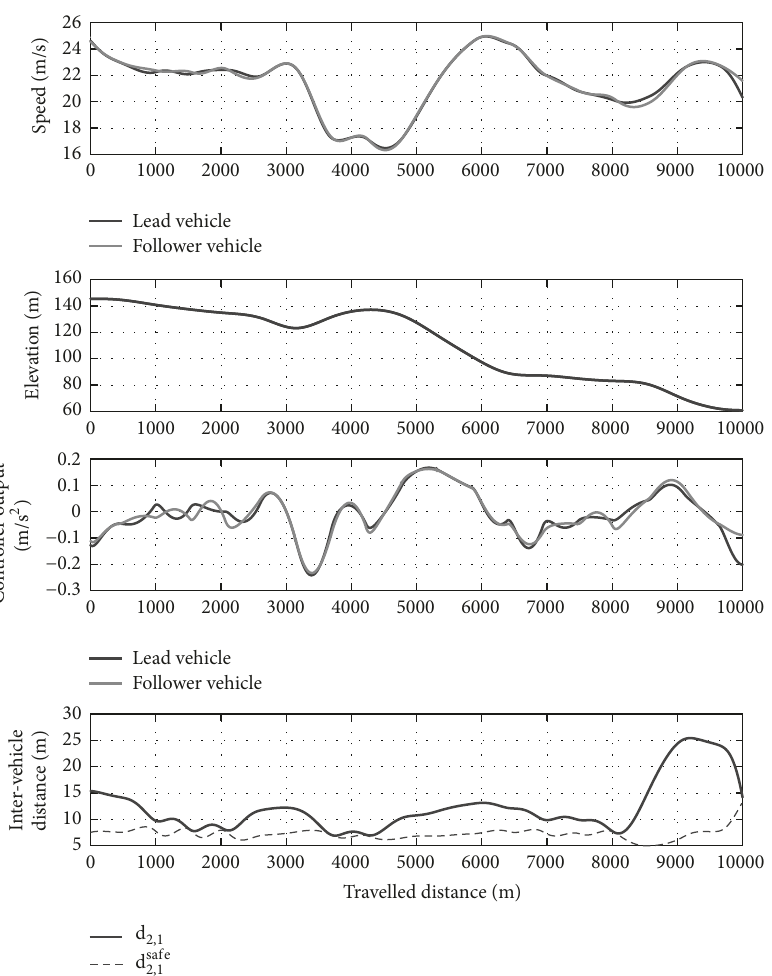
Figure 3: Top panel: one of the ten optimized sets of speed profiles for a homogeneous platoon of two HDVs. Second panel: the road profile. Third panel: the HDV’s controller output 𝑢 along the road, normalized by the total inertial mass 𝑚(𝐺) . Bottom panel: the intervehicledistance 𝑑 𝑑 safe 𝑖,𝑖−1 , (solid line) and the corresponding safe distance, 𝑖,𝑖−1 , and (dashed line) computed using